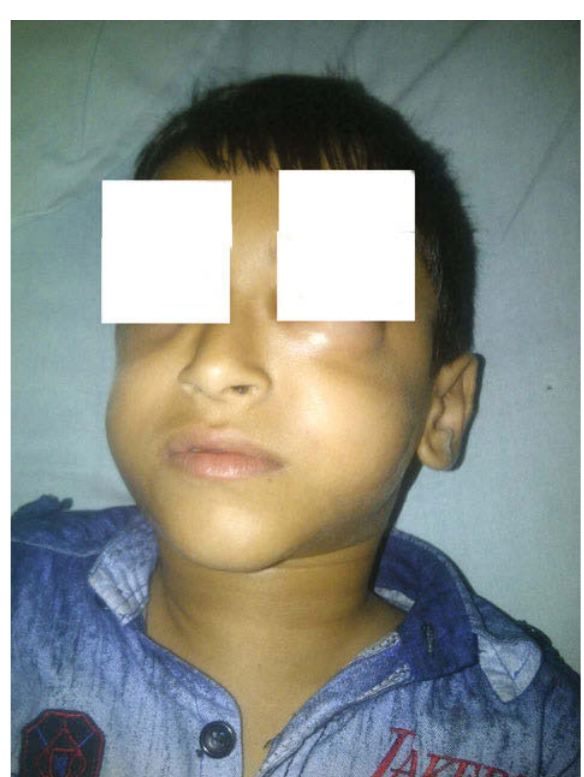
Child with surgical emphysema of the left